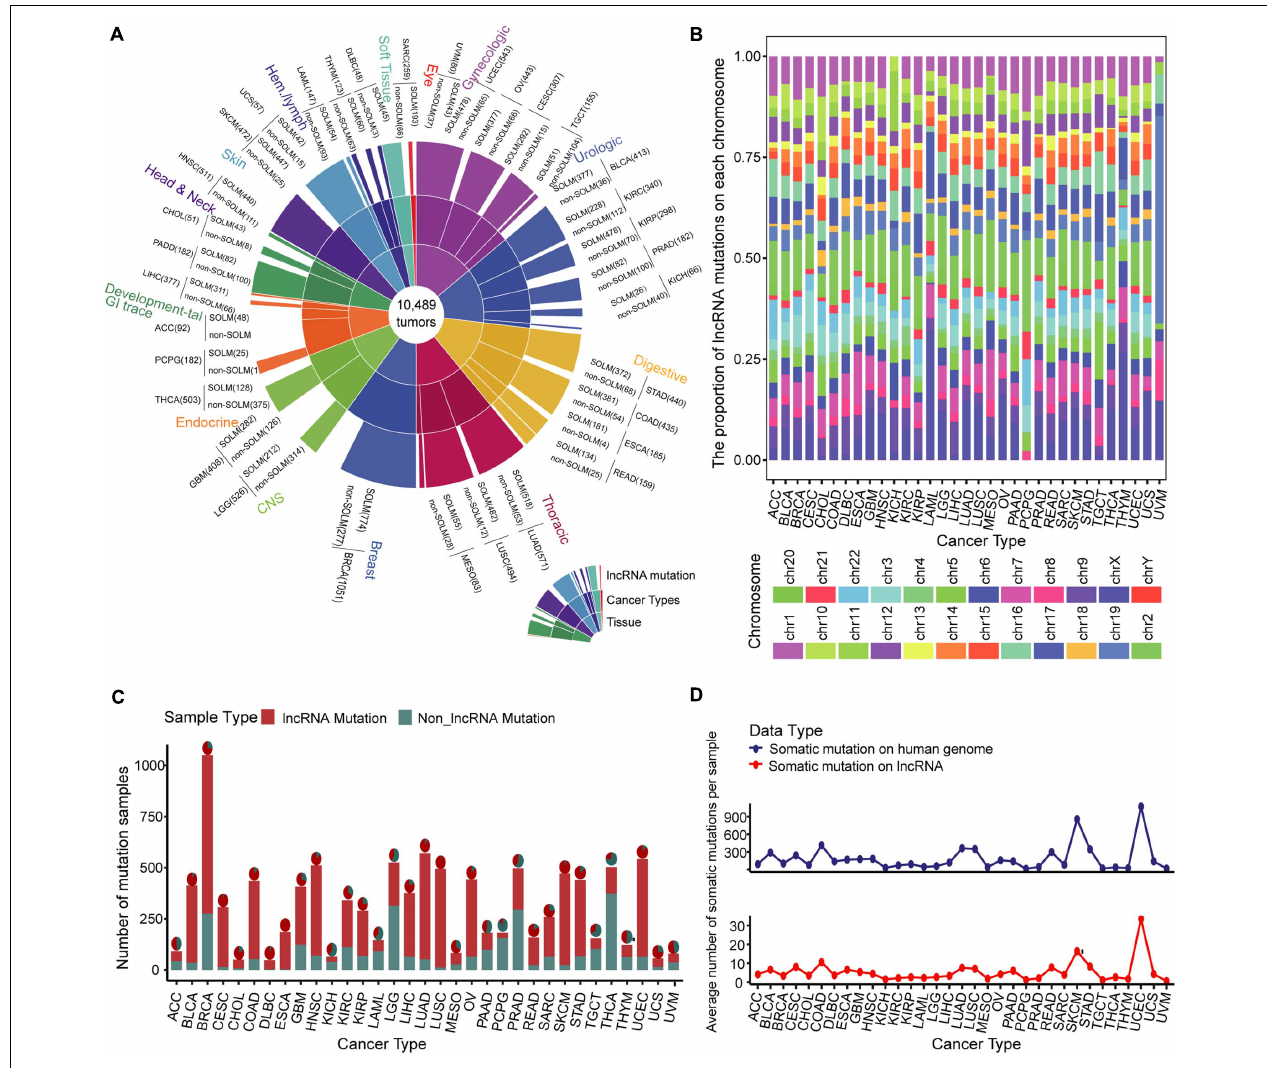
FIGURE 1 | Landscape of somatic mutations across 33 cancer types. (A) Global map of lncRNA mutations in different tissues and cancers. (B) Bar plot of the proportion of lncRNA mutations on each chromosome in multiple cancer types. Twenty-two pairs of homologous chromosomes and two sex chromosomes are marked with distinct colors. (C) Samples with lncRNA somatic mutations are marked in red in 33 cancer type samples. The pie chart illustrates the proportion of lncRNA mutations in all somatic mutations. (D) Average numbers of somatic mutations per sample on the entire genome and lncRNA are presented by line chart across 33 cancer